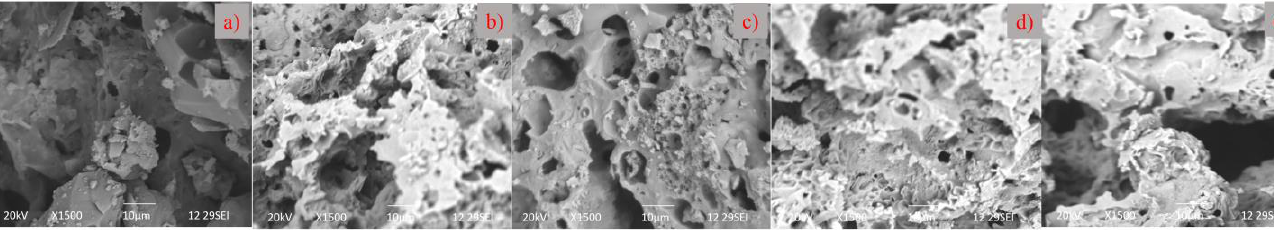
Figure 13. SEM images of concrete specimens exposed to elevated temperature 1000 °C; ( a ) concrete without nanomaterials; ( b ) concrete with NC; ( c ) concrete with NF; ( d ) concrete with NS; ( e ) concrete with NM.